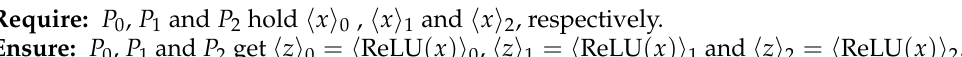
Algorithm 3 SecureReLU Π SR { P 0 , P 1 , P 2